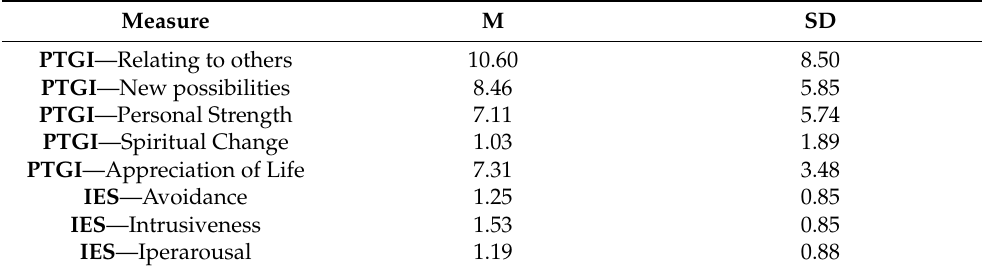
Figure 3. The fraction of patients who scored (% observed frequencies) at or below the normative reference sample (red line) was as follows: 66% for “relating to others”, 50% for “new possibilities”, 50% for “appreciation of life”, 54% for personal strength, and 87% for “spiritual change; subscales ( A – E ). Table 1. Descriptive statistics of the IES-R and PTGI subscales (mean +